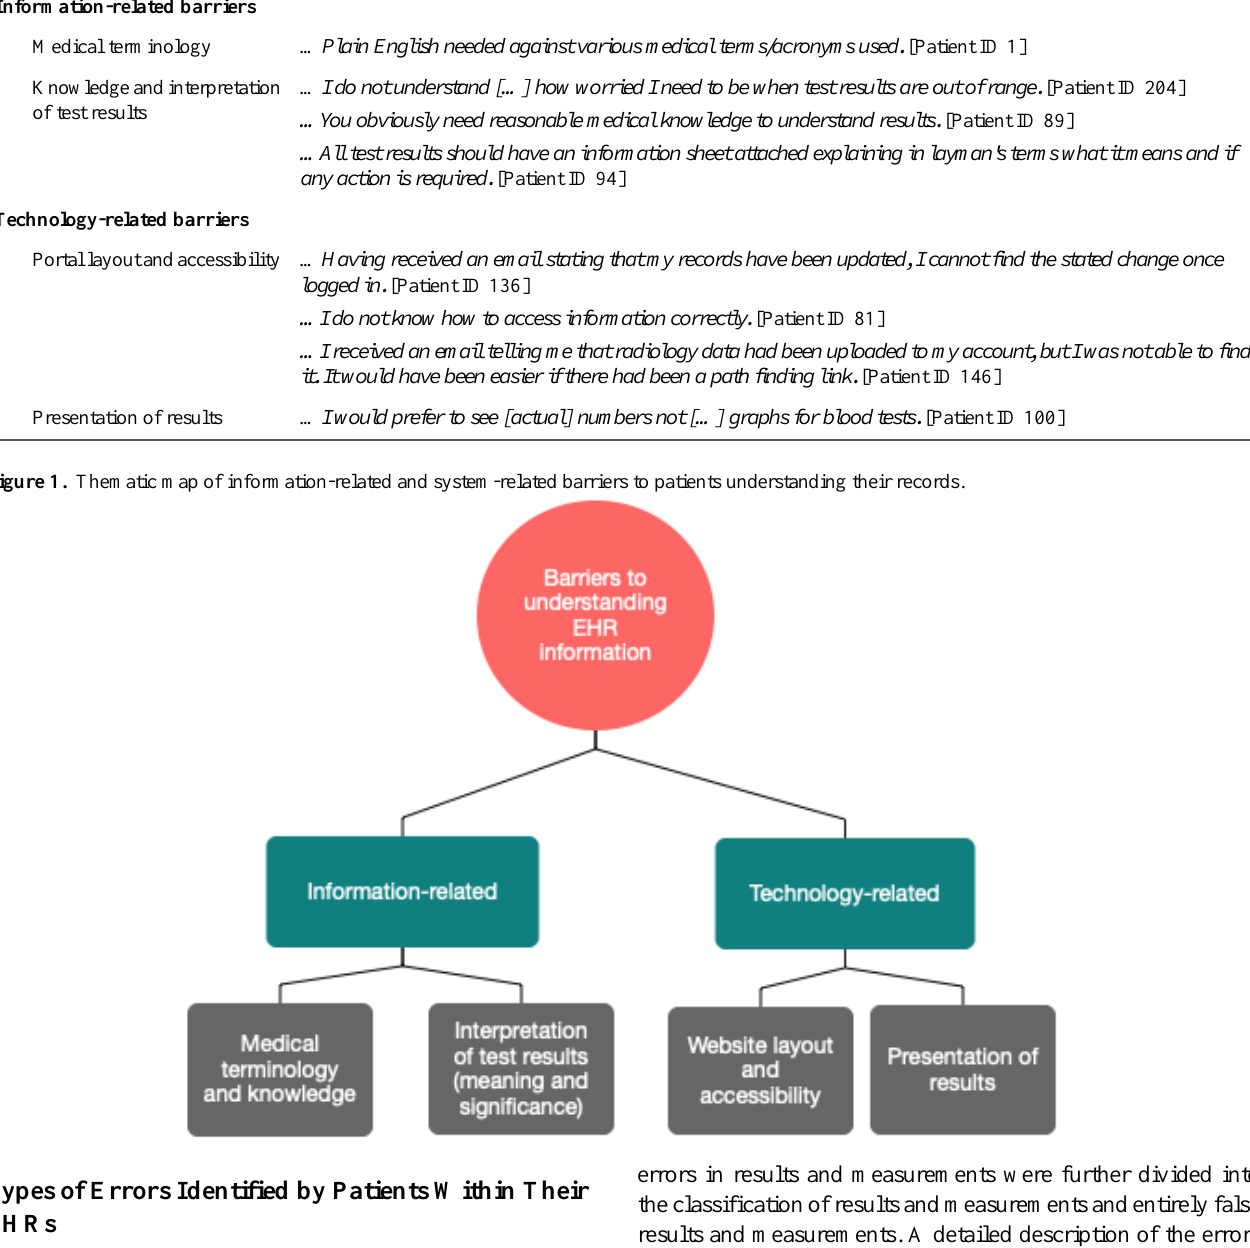
Illustrative quoteBarriers, themes